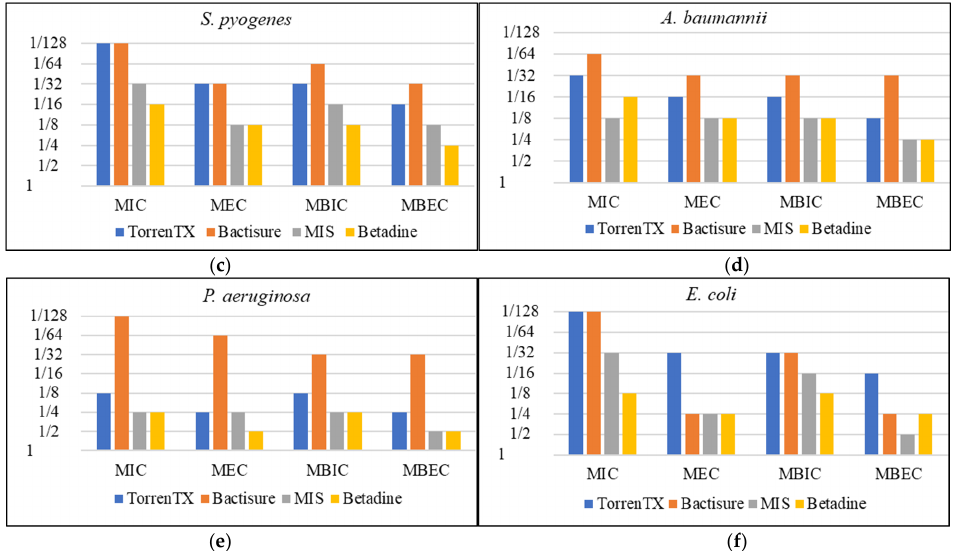
Figure 1. Effect of antimicrobial wound washes on inhibiting growth (MIC) and killing (MEC) planktonic microorganisms and inhibiting growth (MBIC) and killing (MBEC) 1-day-old bacterial biofilms of S. epidermidis ( a ), S. aureus ( b ), S. pyogenes ( c ), A. baumannii ( d ), P. aeruginosa ( e ) and E. coli ( f ).